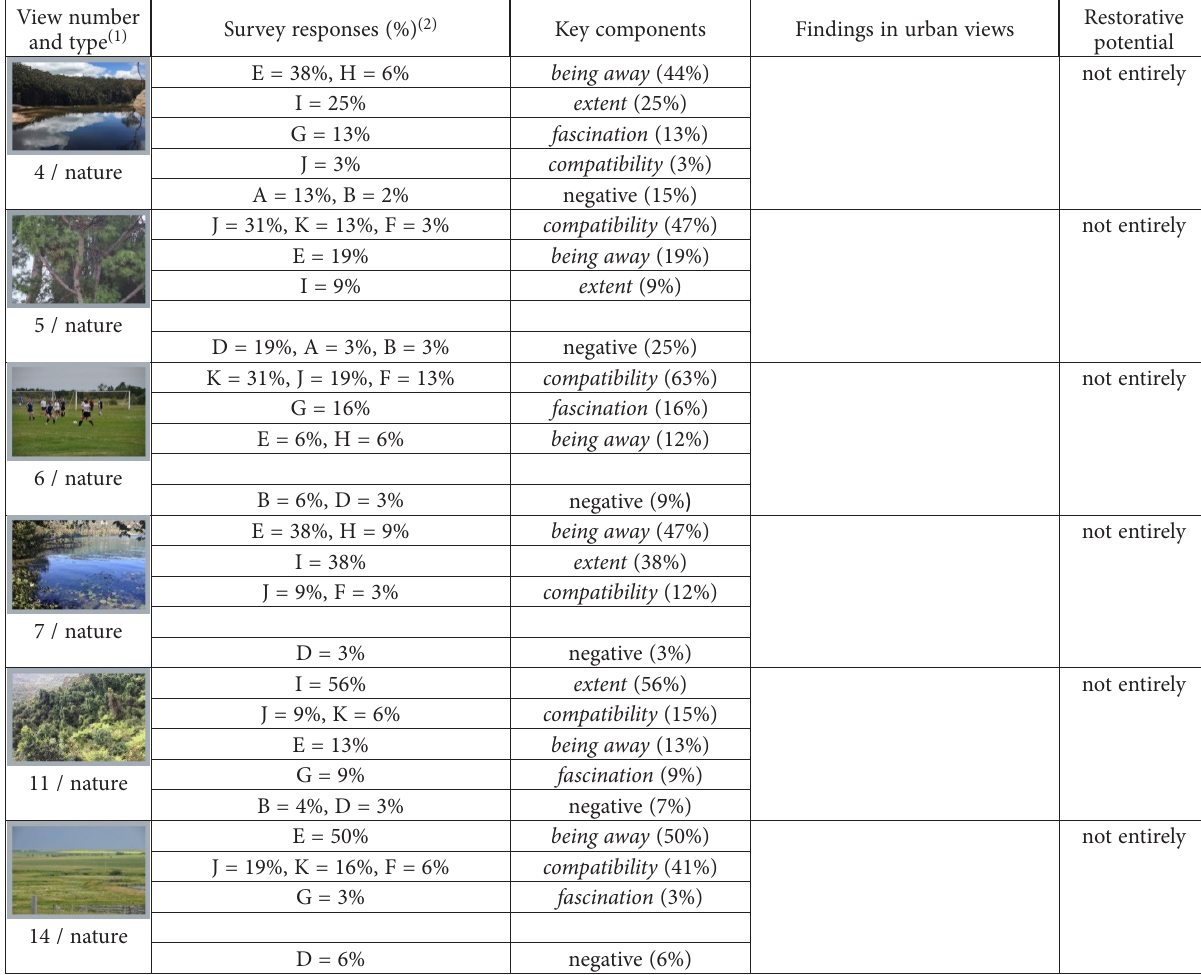
Table 2. Natural window views with minor negative